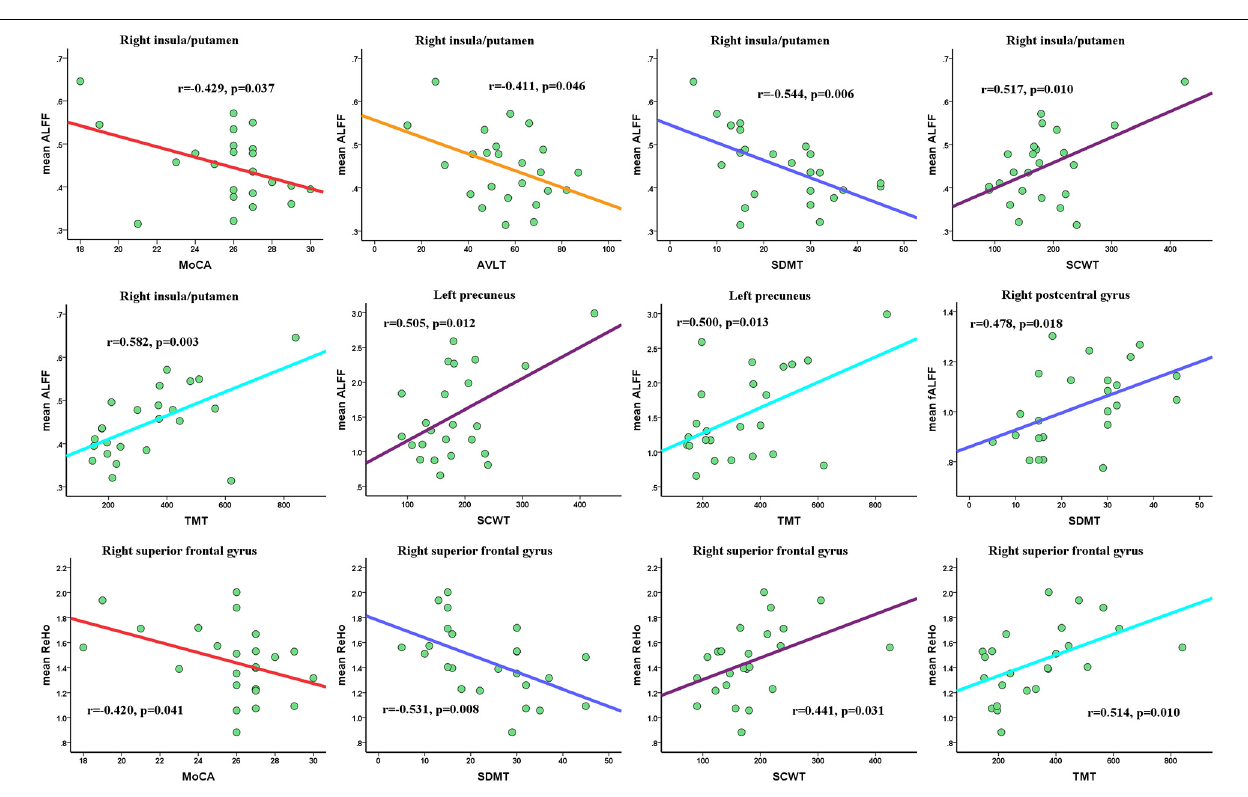
FIGURE 5 | Pearson’s correlations among mean ALFF/fALFF/ReHo values of altered clusters and clinical parameters. Significance was set to p < 0.05. MoCA, Montreal Cognitive Assessment; AVLT, Auditory Verbal Learning Test; SDMT, Symbol Digit Modalities Test; TMT, Trail-Making Test; SCWT, Stroop Color-Word